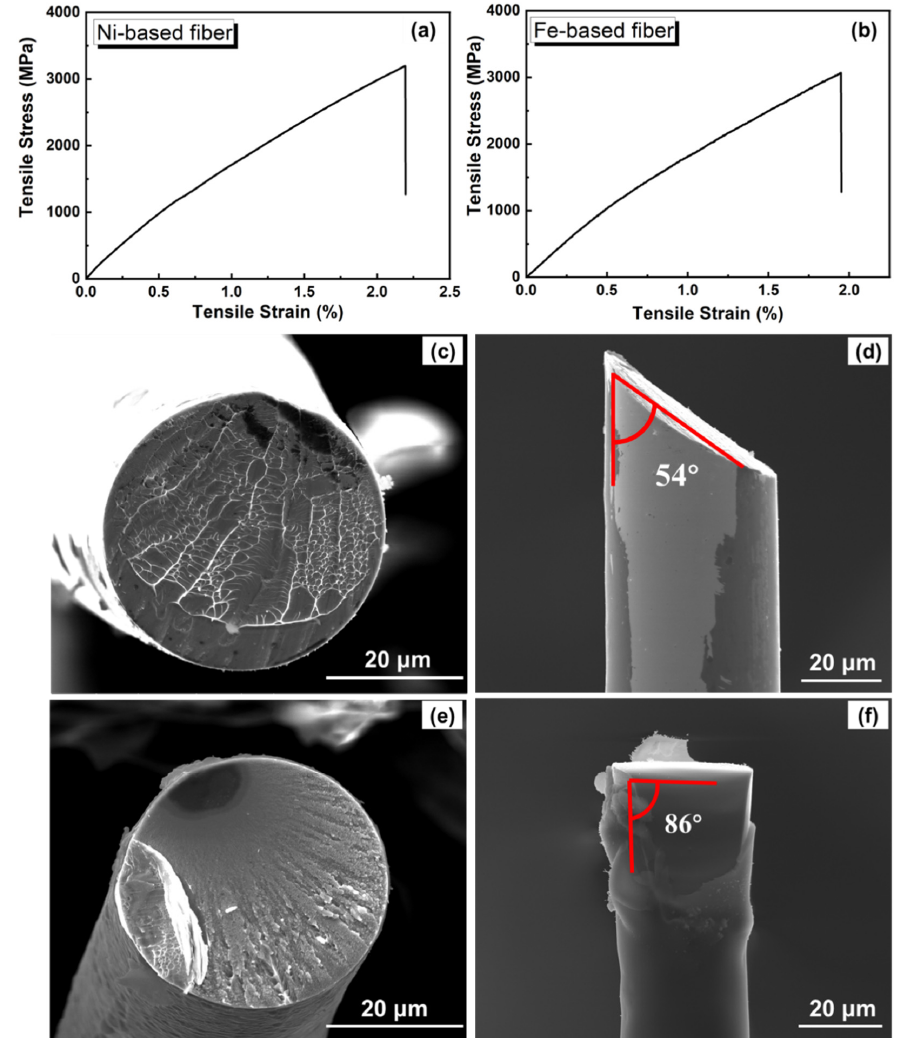
Figure 3. Tensile stress-strain curves of melt-extracted AMFs. ( a ) Ni-based fiber. ( b ) Fe-based fiber, and SEM micrographs after fracture of melt-extracted AMFs. ( c , d ) Ni-based fiber. ( e , f ) Fe-based fiber.